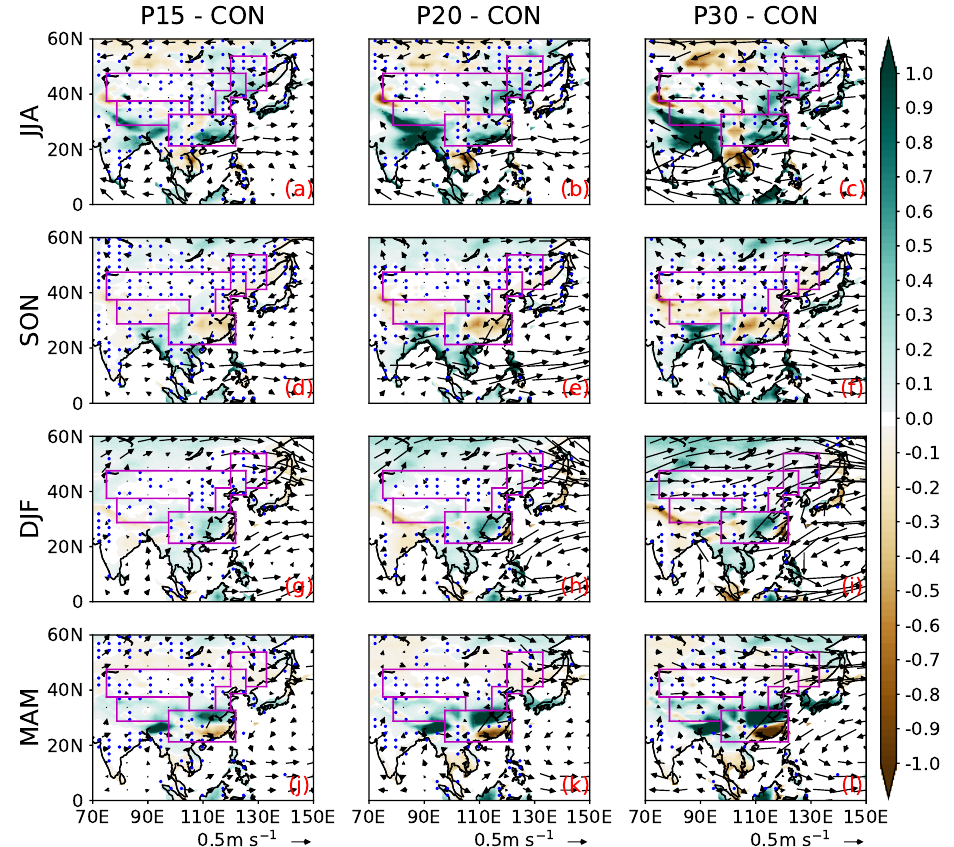
Figure 5. Seasonal-mean ensemble–mean precipitation minus evaporation differences (mm day − 1 ; shaded) for JJA between ( a ) P15 and CON, ( b ) P20 and CON, ( c ) P30 and CON. Other seasons shown are ( d – f ) SON, ( g – i ) DJF, ( j – l ) MAM. The stippling (blue dots) marks regions where less than 70% of the ensemble members agree with the sign of the change. The vectors show the differences in the wind (m s − 1 ) at 850 hPa. The five regions are demarcated by the regional boundaries in